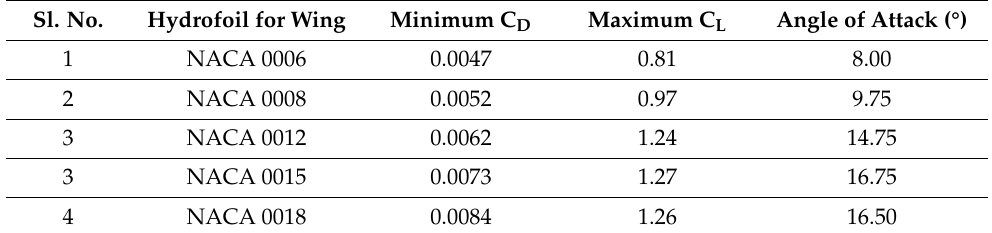
Table 7. Comparative dynamic performance of various symmetrical aerofoils. Sl.